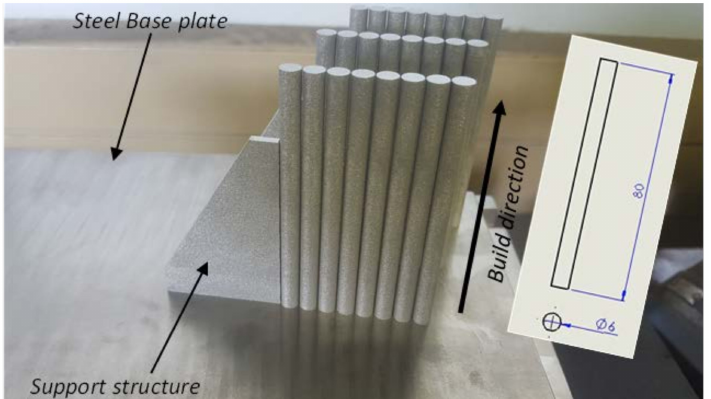
Figure 2. The manufactured SHPB test specimens on DMLS E0SINT M280 machine build platform. The geometrical specifications in mm are shown in the insert of the